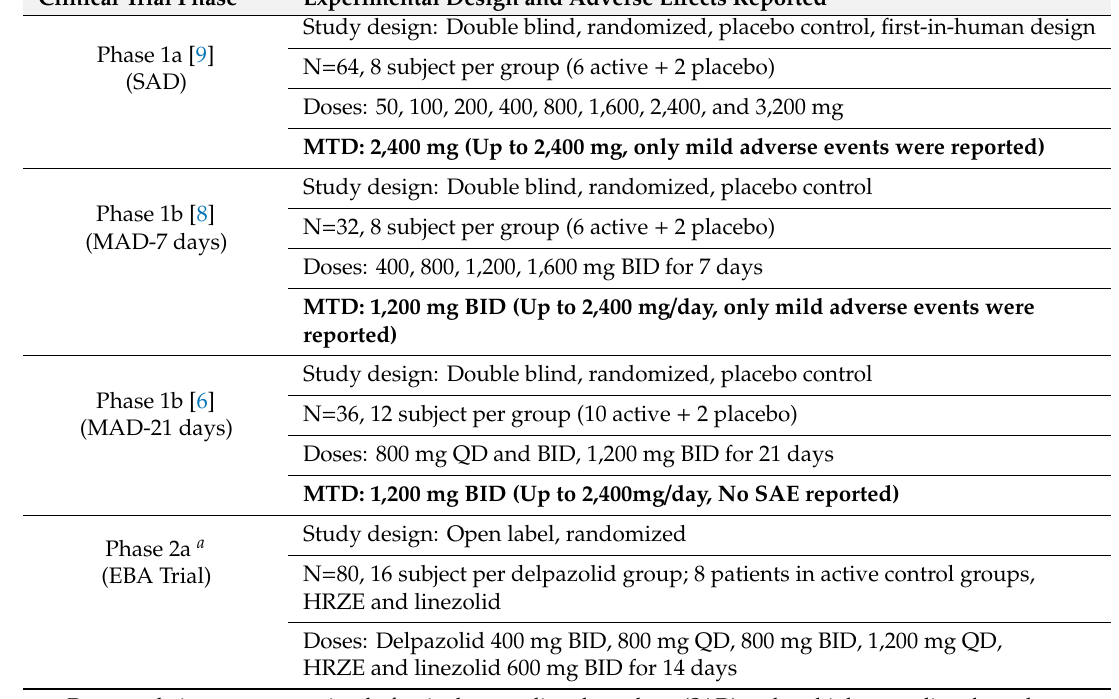
Table 1. Summary of phase 1a / b and 2a dose-escalation study to assess the safety, tolerability, and pharmacokinetics of delpazolid as a single